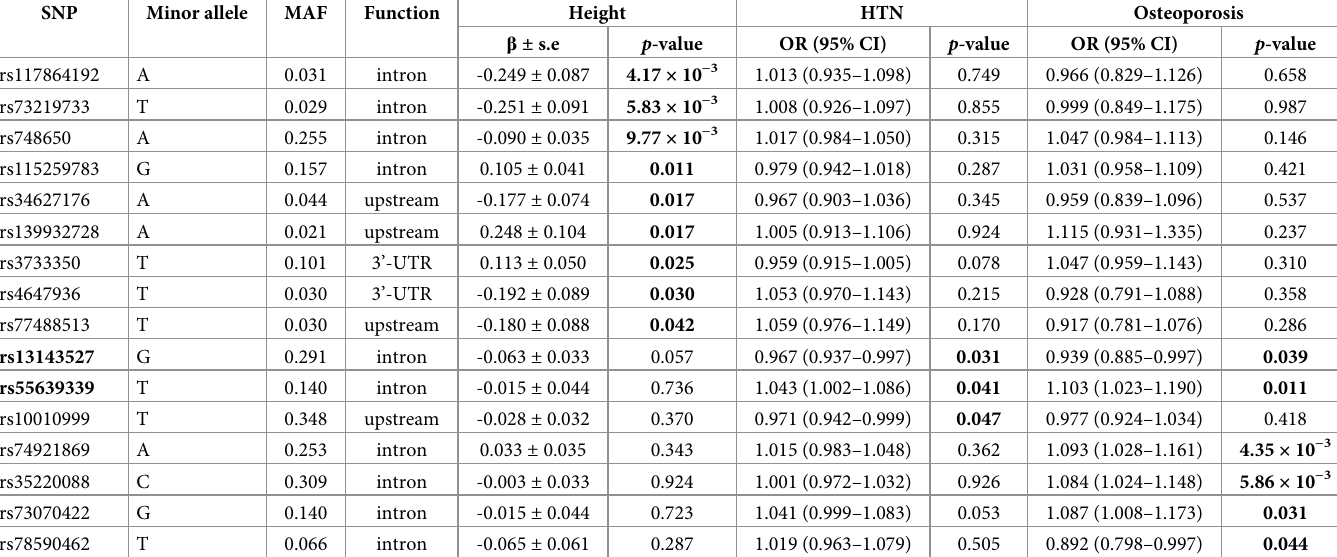
Table 1. Genetic variants in FGFRL1 associated with height, hypertension and